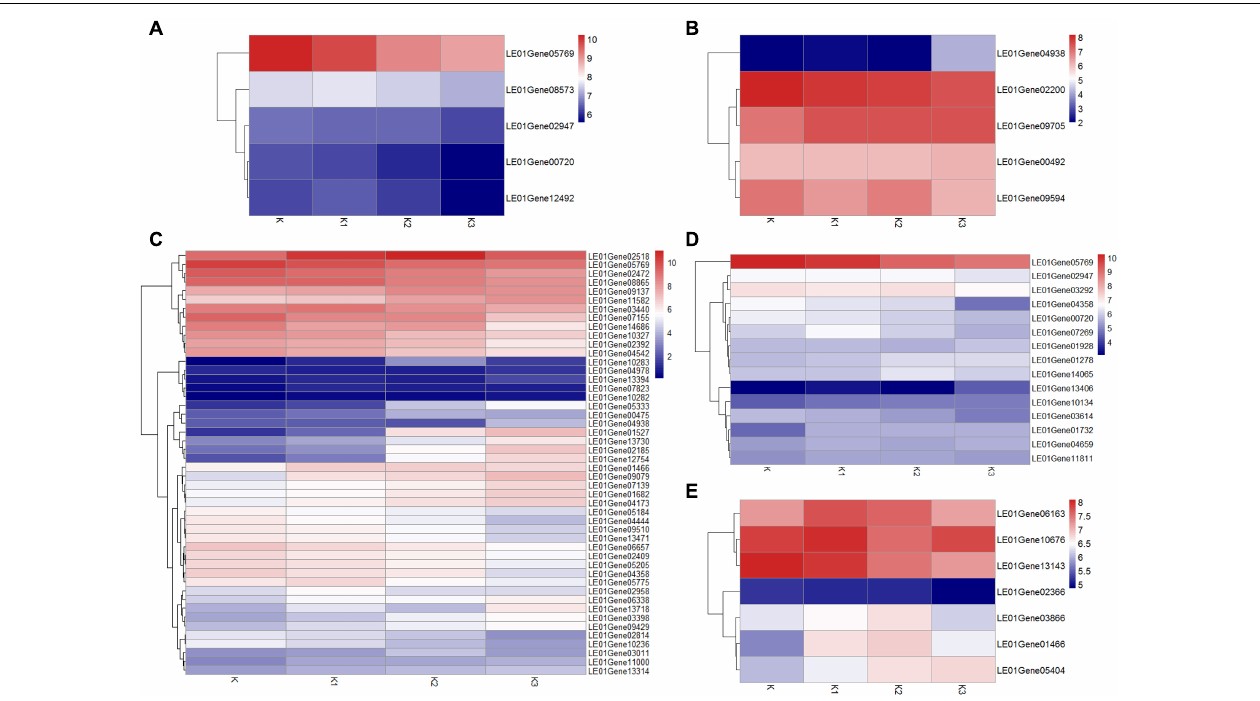
FIGURE 9 | Heatmap analysis of expressed mRNA genes involved in the β -glucan synthesis. (A) Expression of genes involved in β -1,3-glucan synthesis key enzymes. (B) Expression of genes involved in β -1,6-glucan synthesis key enzymes. (C) Expression of DGEs. (D) Expression of genes involved in cell wall stress of MAPK signaling pathway-yeast. (E) Expression of genes involved in glycogen accumulation of longevity regulating